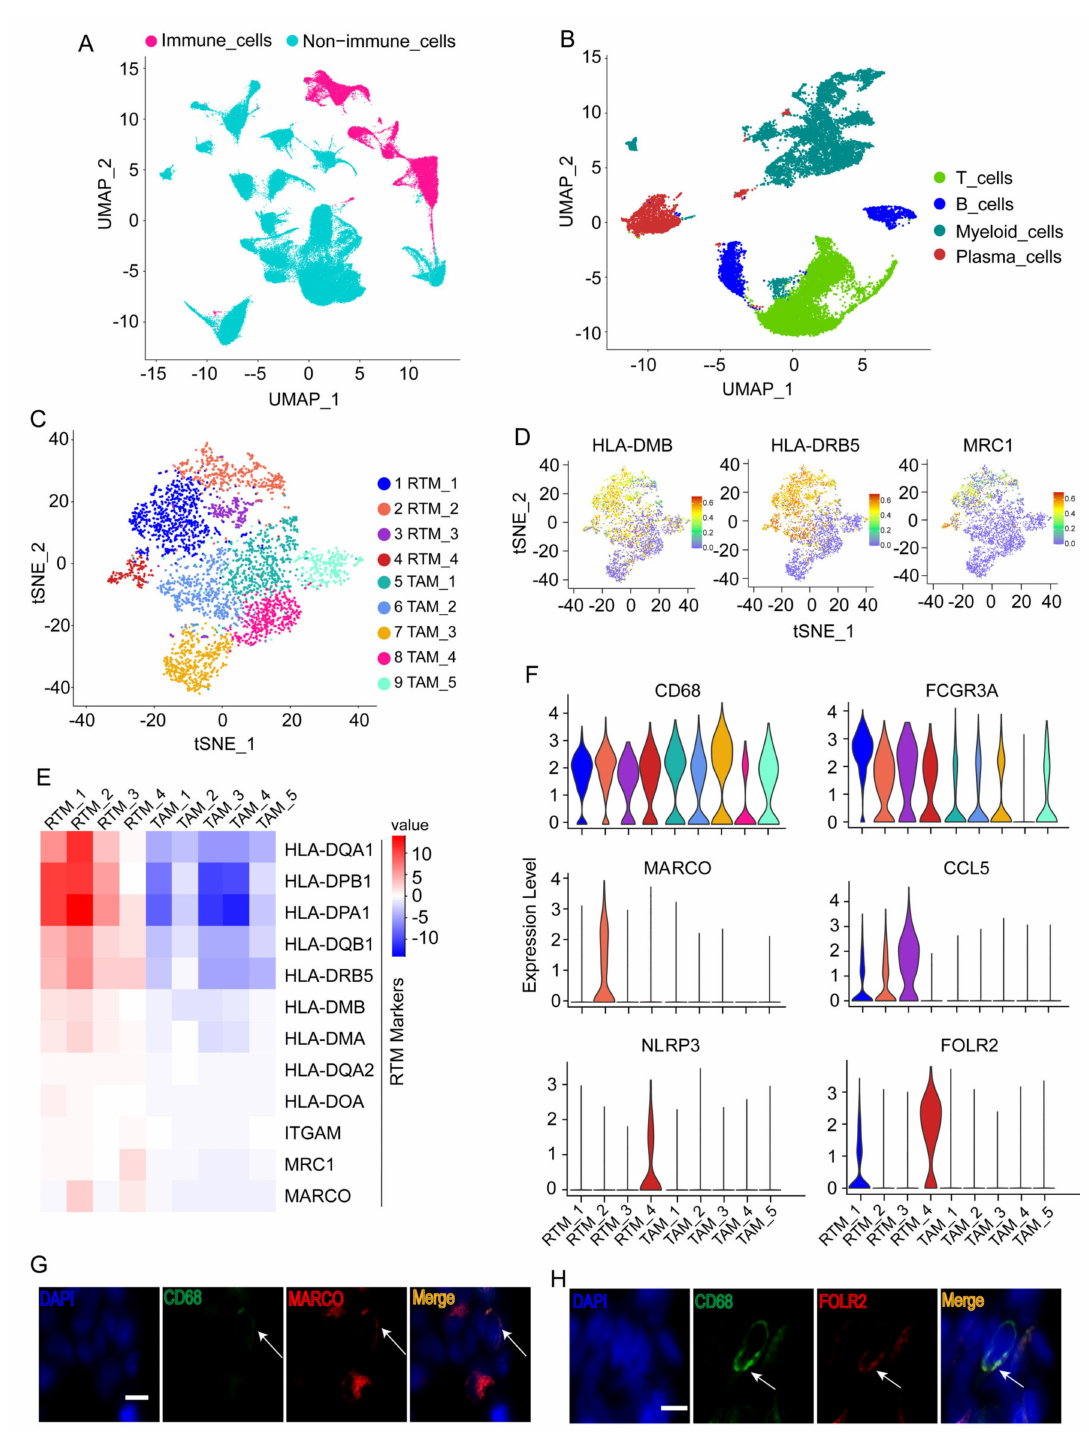
Figure 1. Identification of tissue-resident macrophages (RTMs). ( A ) UMAP plot of immune cells or non-immune cells. ( B ) UMAP plot of major immune cell types. ( C ) t-distributed stochastic neighbor embedding (t-SNE) plots displaying 10 macrophage clusters. ( D ) t-SNE plots showing the expression levels of representative genes. ( E ) Heatmap exhibiting the expression levels of representative genes across 10 macrophage clusters. RTM, tissue-resident macrophage; TAM, tumor- associated macrophages. ( F ) Violin plots showing the expression of RTM cluster-specific genes across five RTM clusters. RTM_1 cluster had no specific marker. ( G , H ) Immunofluorescence staining of CD68, MARCO ( G ), and FOLR2 ( H ) in BC tissues. Scale bar, 20 µ